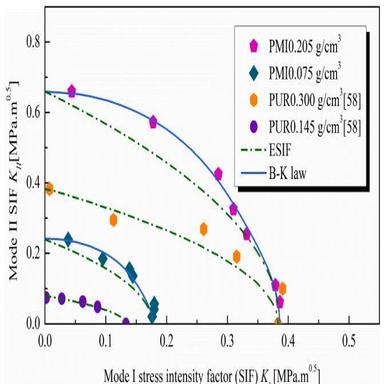
Comparison of the mixed mode fracture between PMI and PUR foams with different densities. Two fracture criteria are introduced predict the mixed mode fracture of PMI foam, namely equivalent stress intensity factor (ESIF) and B-K law.